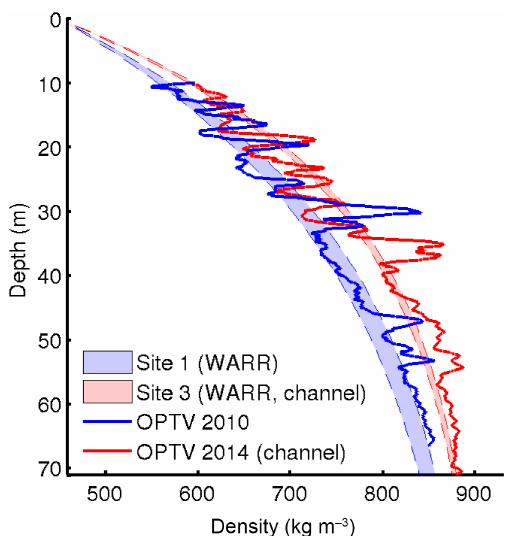
Figure 7. Depth profiles of density derived from WARR (dashed) and OPTV (solid). WARR data are from Sites 1 and 3, closest to the OPTV sites. Site 3 and the 2014 borehole are both in the trough of an ice-shelf channel (Fig. 2). The envelopes of the radar- derived densities correspond to the lower and upper limit of five reflector combinations used for the inversion. The OPTV logs were smoothed with a 0.5m running